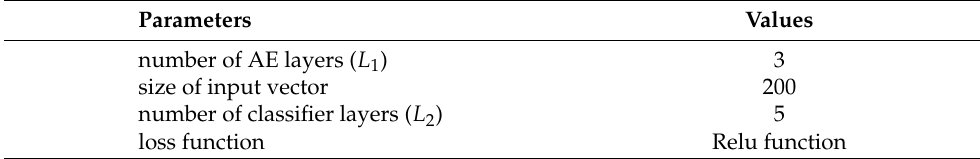
Figure 8. Performance comparison of DAE and CAE with two different signal sources: ( a ) accuracy of two incident angles θ 1 = 10 ◦ and θ 1 = 12 ◦ within the same subregion versus SNR, ( b ) accuracy of two incident angles θ 1 = 10 ◦ and θ 1 = 30 ◦ in different subregions versus SNR. Table 2. System parameters of the DAE structure.